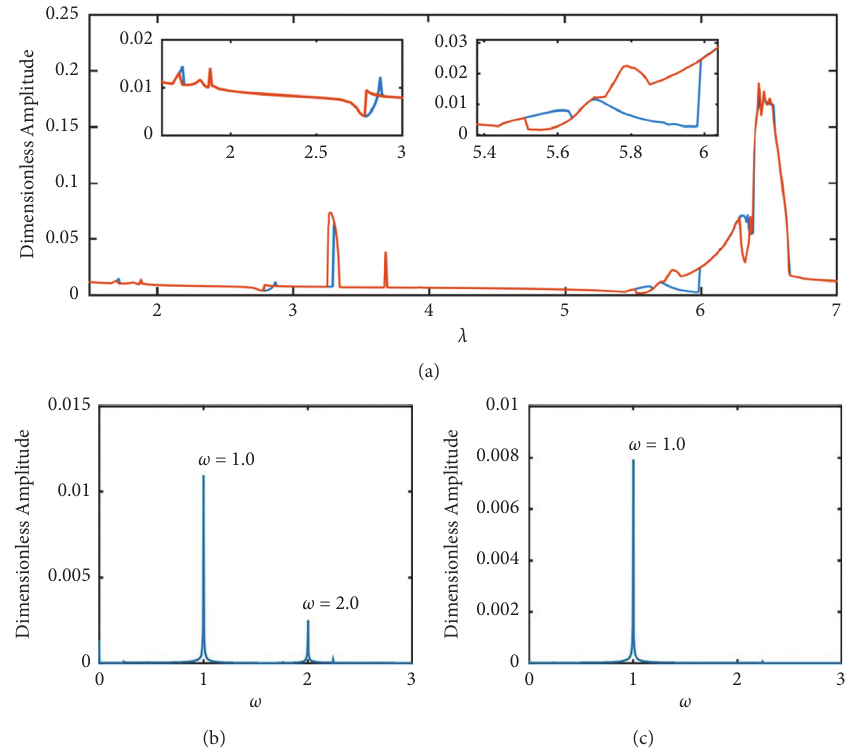
Figure 9: The amplitude-frequency curves and spectrums of responses of disc in horizontal direction when N frequency curves, (b) λ � 2 . 87 (run-up), and (c) λ � 2 . 87 (run-down) (blue line means run-up process and brown line means run-down process).